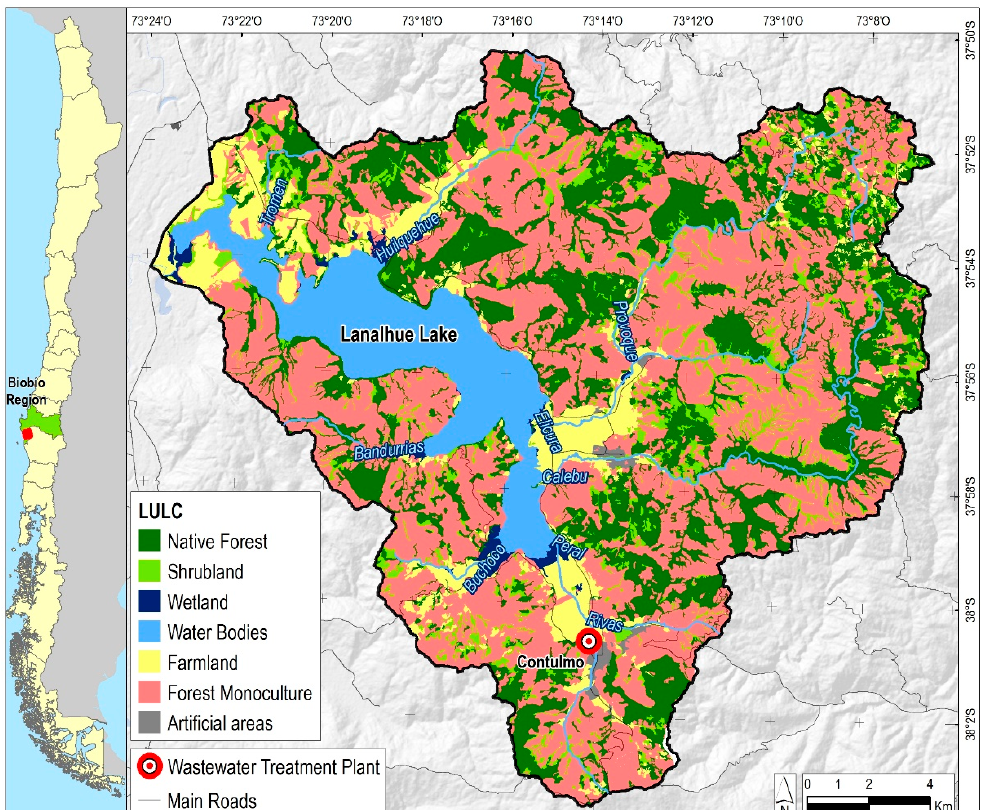
Figure 1. Location of the Lanalhue Lake and current land use. Forest monoculture represents 43%, the native forest is close to 22%, water bodies and farmlands are approximately 19% (in total), and the rest of the land use (shrubland, mixed forest, wetlands, and urban areas) corresponds to 16%. Land use in the Lanalhue Lake basin has been affected by changes from native forest cover to monoculture forestry plantations Pinus radiata and Eucaliptus globus , which have entailed a modification of hydrological components, increasing the export of sediment and nutrients from the basin to the lake [38]. Additionally, the lake is highly influenced by buildings not served by a wastewater treatment plant and recreational activities (e.g.,